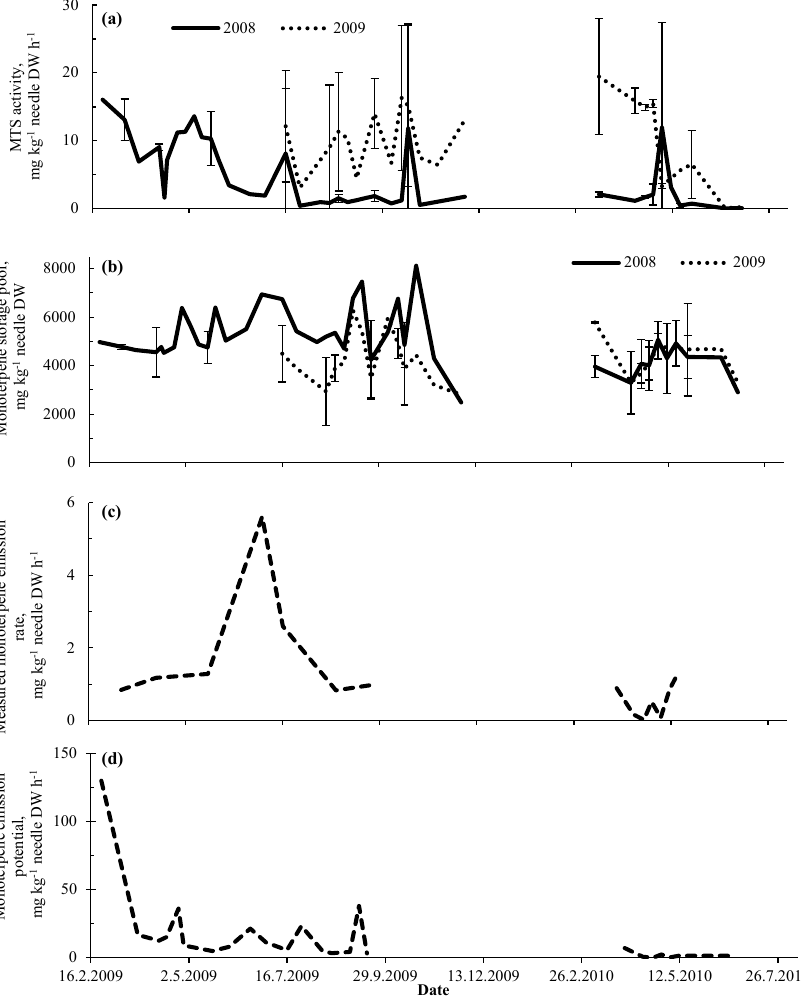
Figure 3. The synthase activities of α -pinene, β -pinene, camphene and δ -3-carene (sum, a ), the storage pools of the same compounds (sum, b ), their measured emission rates (sum, c ) and emission potentials (standardized to 30 ◦ C) (sum, d ) as functions of time. In (a) and (b) , the curves show the means ± 1 standard deviation of the samples of different needle age classes (grown in 2008 and 2009) collected from trees #3 and #4. Missing error bars represent the dates when data were only available from one tree. In (c) and (d) , the emissions originate from a shoot of tree